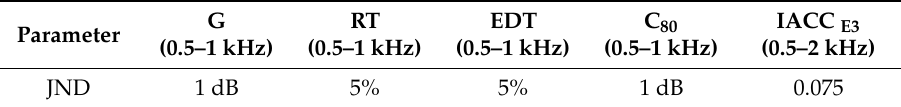
Table 1. JND for objective